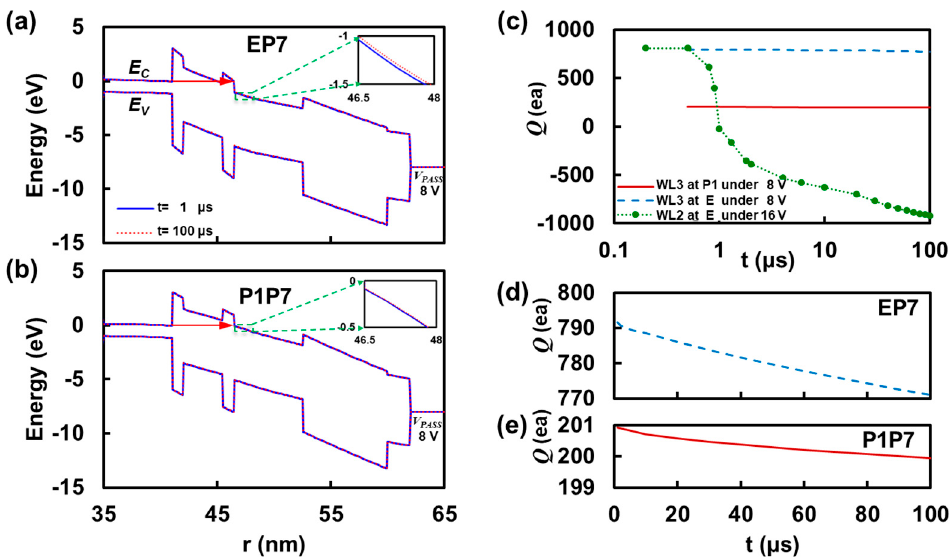
Figure 3. Band diagram of the victim cell (WL3) along the radial direction of a cylindrical cell string and corresponding number of trapped charges in the trap-nitride layer as a function of time while programming WL2 with V PGM = 16 V and V PASS = 8 V. ( a ) WL3 at the state E exhibits Fowler–Nordheim tunneling due to lowered conduction band edge by trapped hole charges in the trap-nitride layer. ( b ) WL3 at the state P1 depicts the harsher tunneling barrier compared to that of E in Figure 4a. This is because the net charge in the trap-nitride layer is less positive compared to E(erase) state so that the electrostatic potential is higher. ( c ) Number of trapped charges ( Q ) in the trap-nitride layer of WL2 beginning from the state E as a function of time under programming voltage V PGM = 16 V is shown (green dotted line) together with that of victim cell under two different states (E and P1). ( d ) WL3 at E under the bias V PASS = 8 V shows the charge in Q from +792 to +771, implying about 20 electrons were tunneled and holes were canceled. ( e ) WL3 at P1 shows negligible change in Q (from +201 to +200) so that the interference (121 mV for B-T and 88 mV for T-B) purely comes from the adjacent cell’s channel inversion.